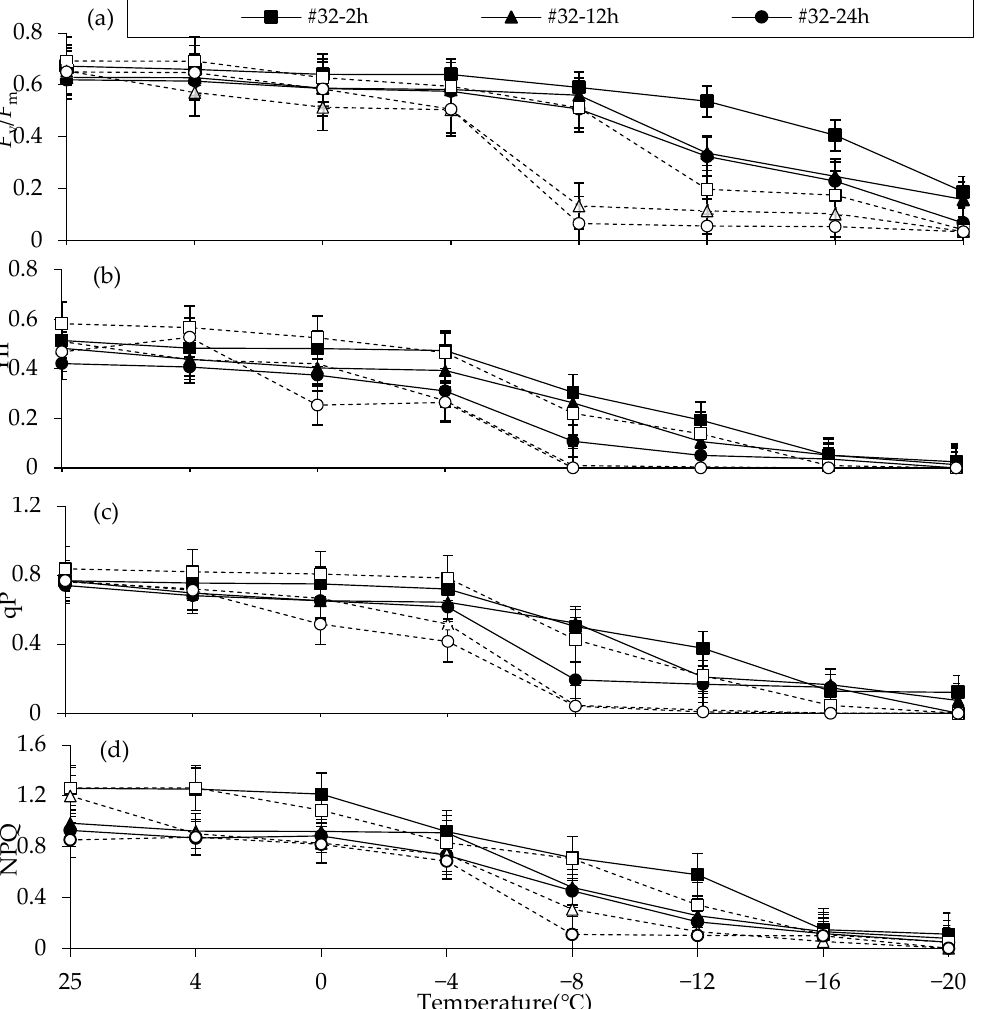
Figure 4. Changes of chlorophyll fluorescence in C. fortunei clones under different low ‐ temperature stress. ( a ) Changes of F v /F m ratio; ( b ) changes of the effective quantum yield of PSII (YII); ( c ) changes of photochemical quenching (qP); ( d ) changes of non ‐ photochemical quenching (NPQ). Each value is the mean ± standard error, n = 6.